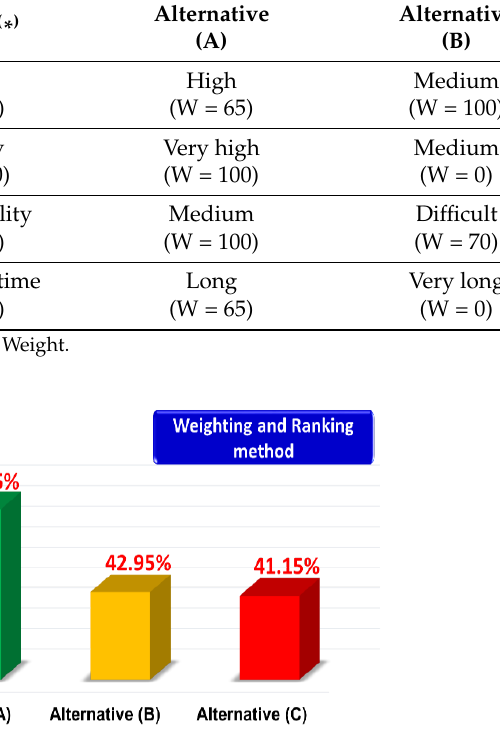
Table 2. Application of weighting and ranking method. Figure 10. Solution alternatives and differentiation criteria: ( a ) the nominated three alternatives; ( b ) the four criteria for differentiation between alternatives.